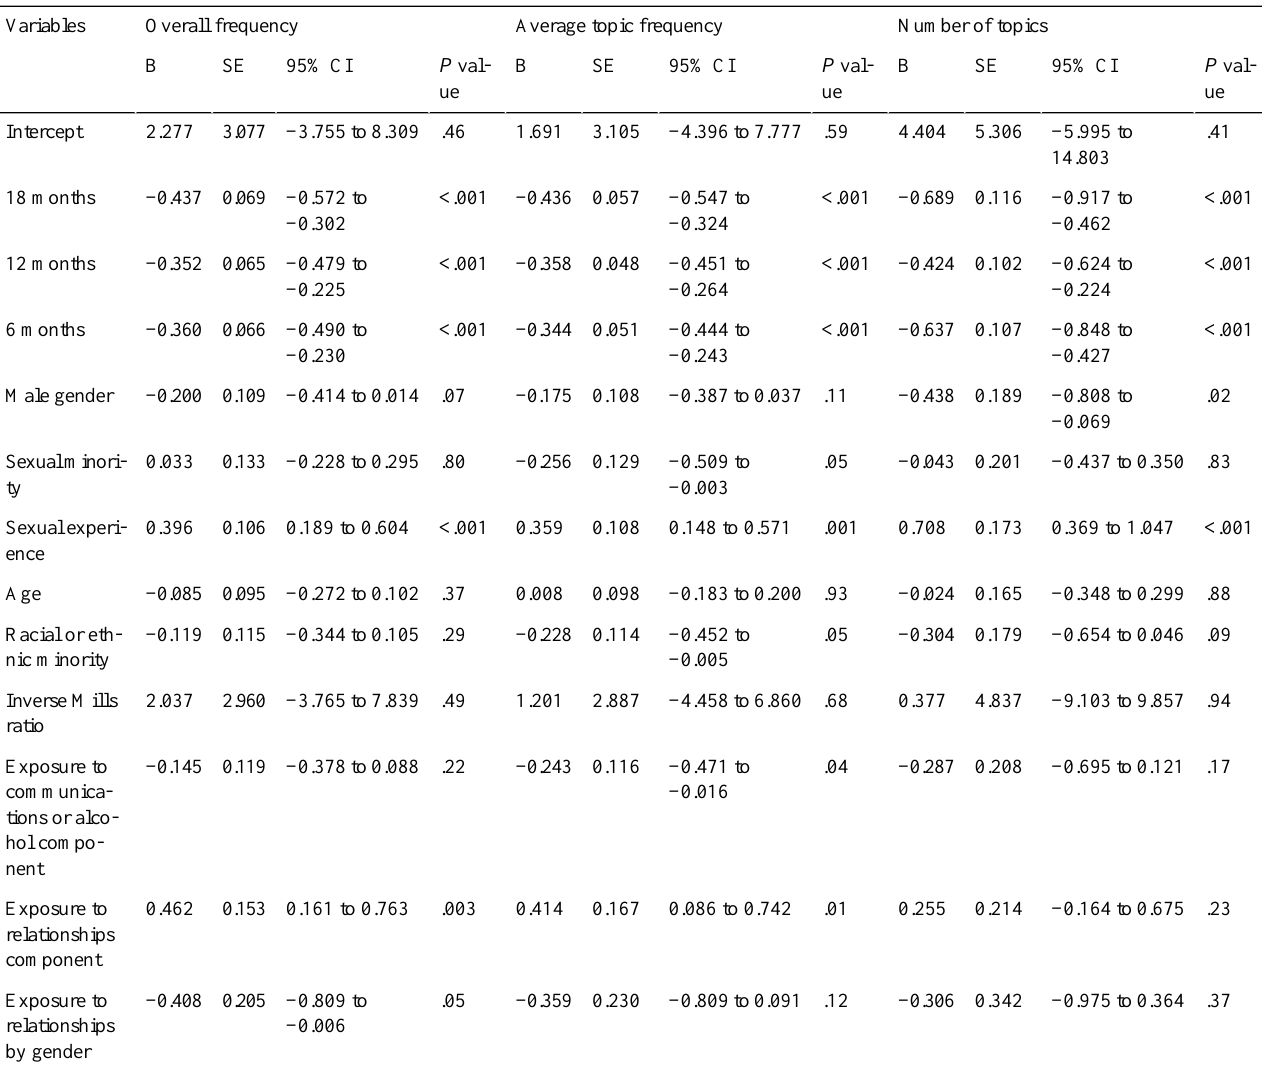
Table 5. Results from generalized estimating equations: interaction effects of intervention exposure on adolescent report of sexual communication by gender: topics (T0: n=411; T1: n=325; T2: n=311; T3: